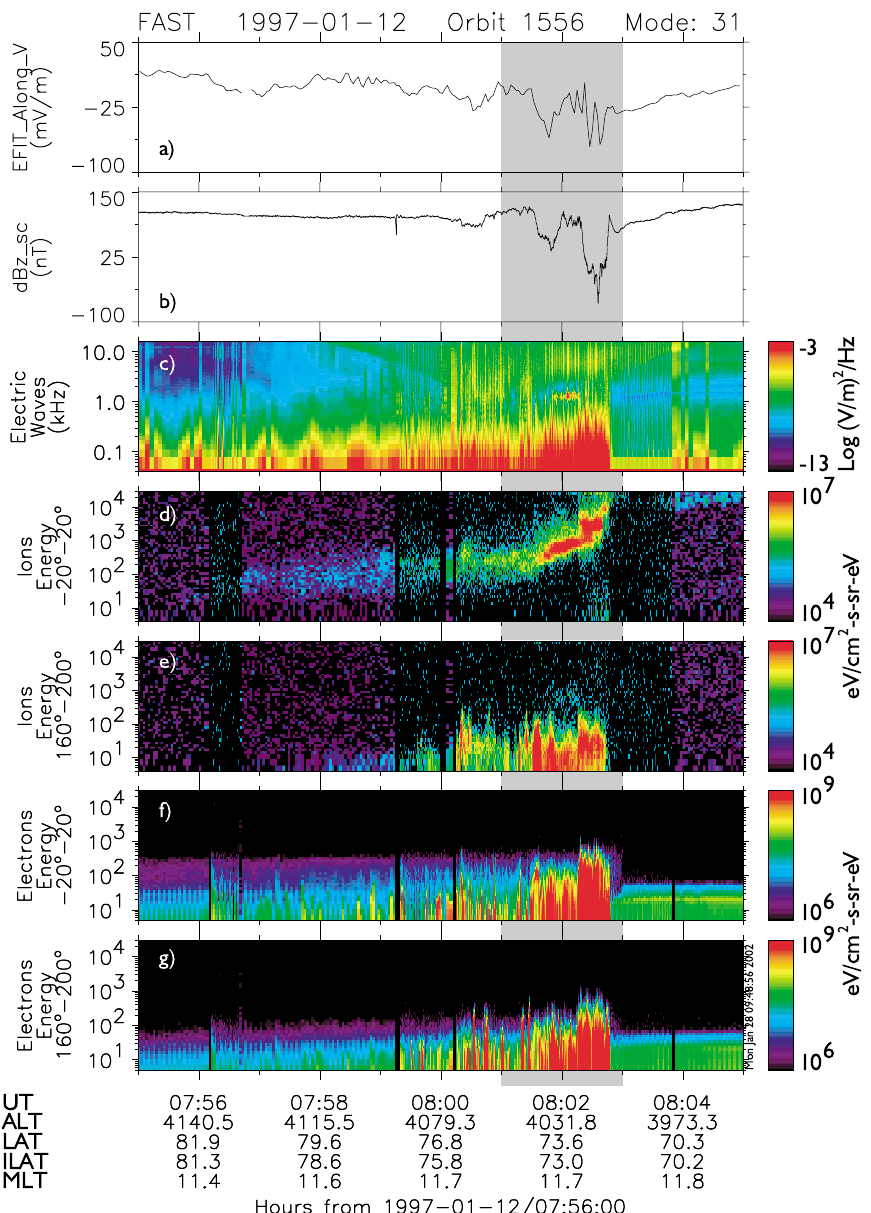
Fig. 4. FAST particle and field data from 07:55 to 08:05 UT. The seven panels show: (a) DC electric fields along the spacecraft velocity vector, (b) spin-axis component of the DC magnetometer oriented perpendicular to the orbital plane, (c) electric field wave spectrogram, (d) energy-time spectrogram for precipitating ions with pitch angles of − 20 ◦ to 20 ◦ , (e) energy-time spectrogram for outflowing ions with pitch angles of 160 ◦ to 200 ◦ , (f) energy-time spectrogram for precipitating electrons with pitch angles of − 20 ◦ to 20 ◦ , and (g) energy-time spectrogram for outflowing electrons with pitch angles of 160 ◦ to 200 ◦ . The grey shading indicates the time interval shown in Fig. 6 and the interval between the two white arrows in Fig.